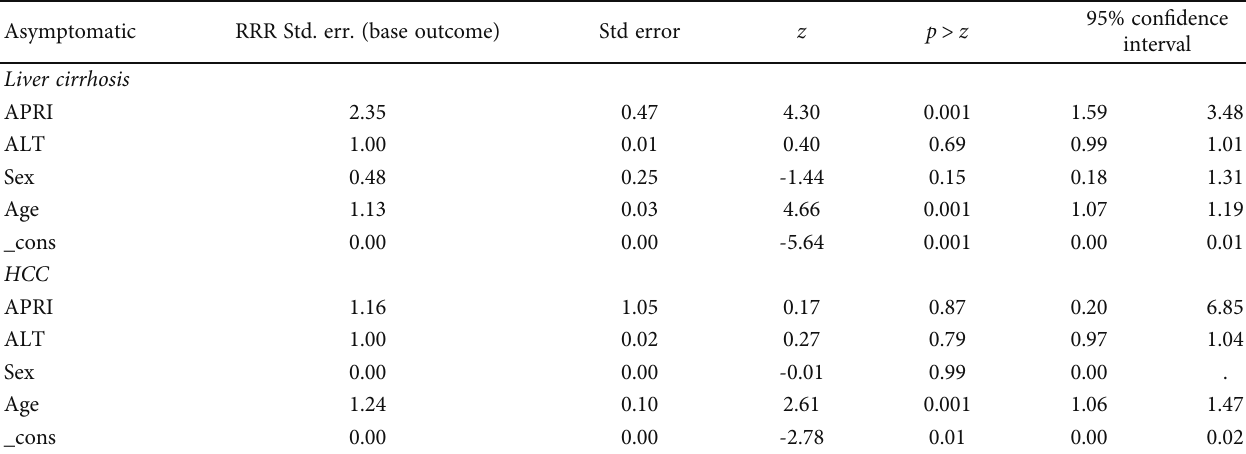
Table 4: Predictors of liver cirrhosis and HCC.